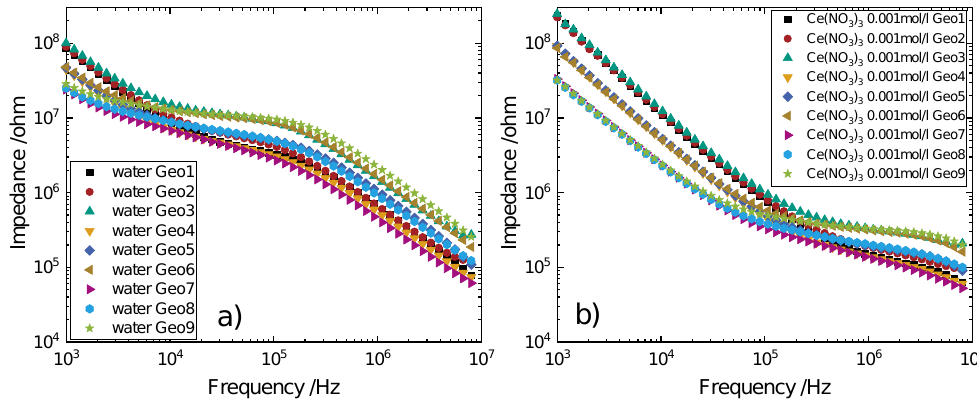
Figure 4. Impedance over frequency for deionized water ( a ) and cerium nitrate ( b ) with different electrode geometries, which are mentioned in Table